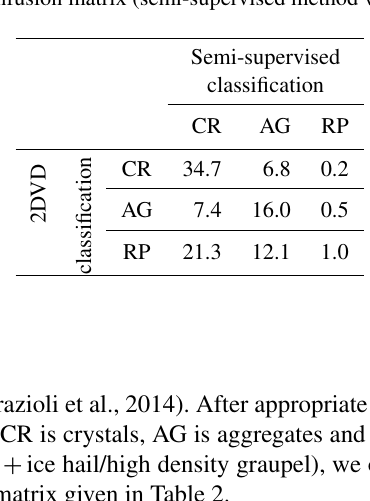
Table 2. Confusion matrix (semi-supervised method vs. 2DVD). Table 3. Cohen’s kappa and overall